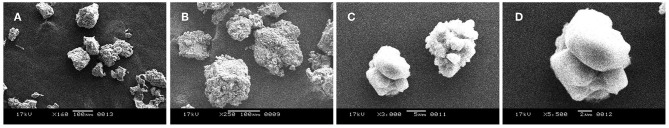
Scanning Electron Micrograph (SEM) images of purified Exo1 showing compact globular nature (A–D).